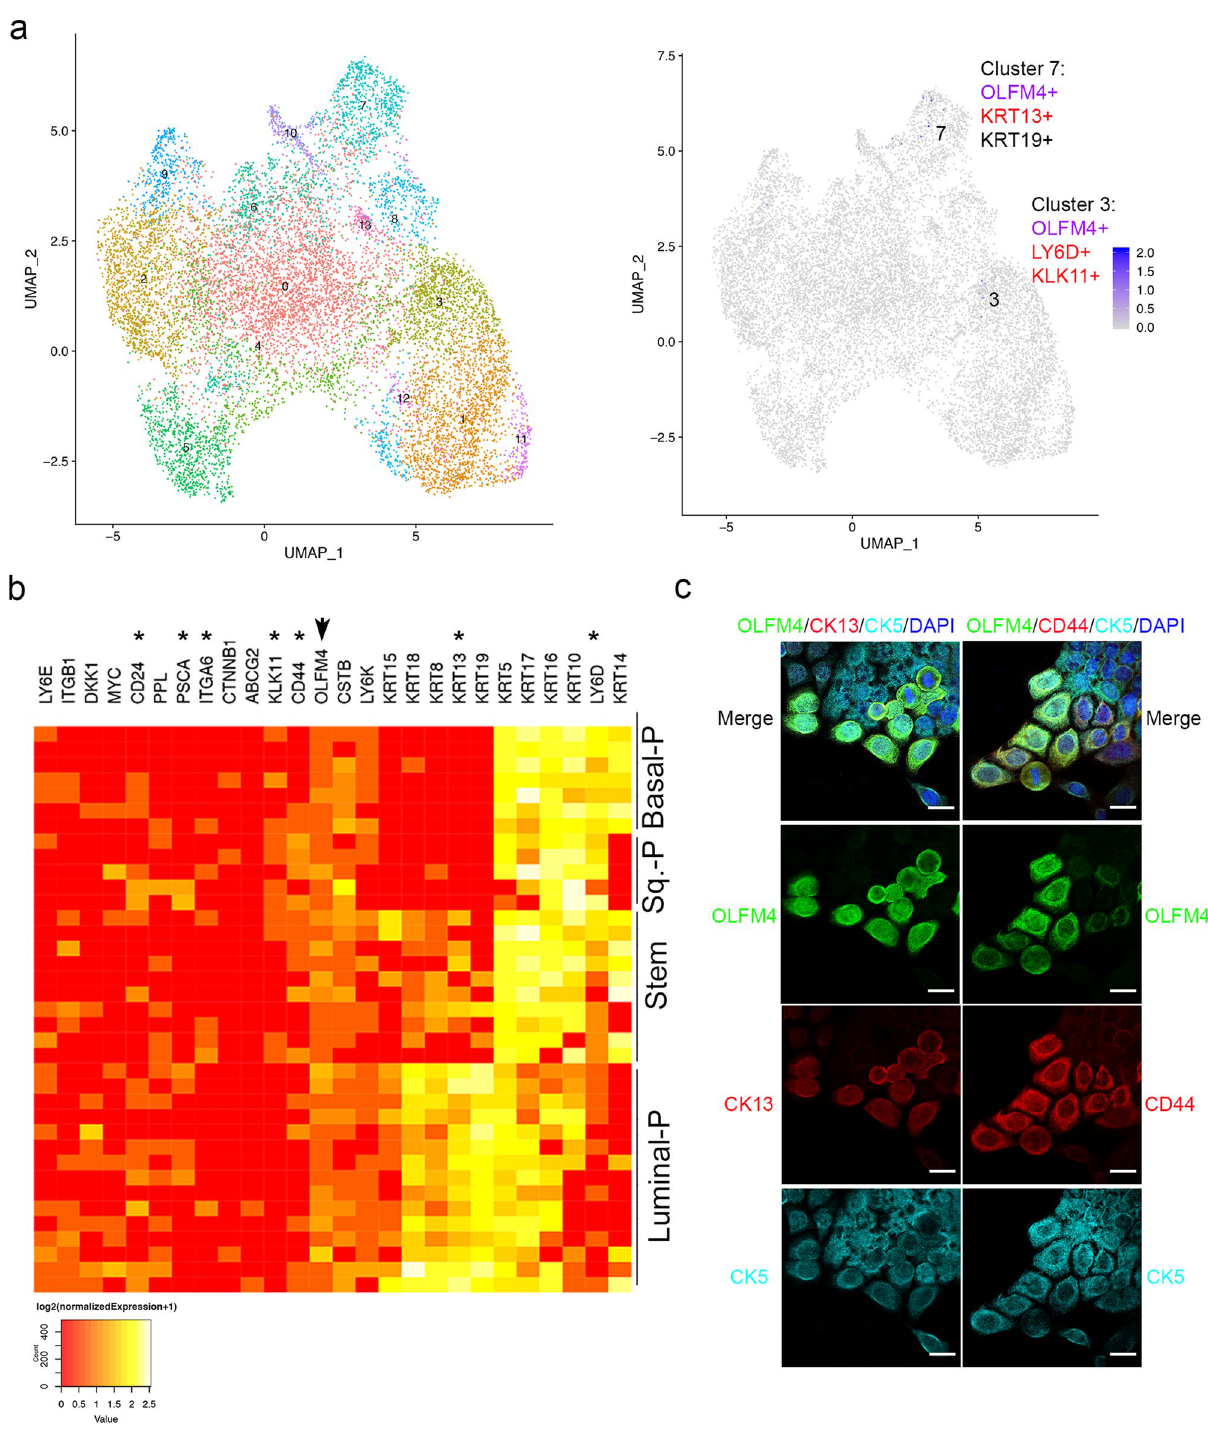
Figure 2. Identification of OLFM4 -expressing RWPE1 cells. ( a ) Uniform Manifold Approximation and Projection (UMAP) plots of integrated data from single-cell RNA sequencing of RWPE1 cells. Left panel shows 13 clusters of total RWPE1 cells; right panel shows OLFM4-expressing cells (purple color) in clusters 3 and 7. ( b ) Heat map illustrates OLFM4 co-expression with stem/progenitor-cell marker genes, cytokeratins, and others in 37 OLFM4-expressing RWPE1 cells. Sq., squamous. P, progenitor. *Indicates lines for stem/progenitor-cell marker genes; arrow indicates line for the OLFM4 gene. ( c ) Representative triple-color immunofluorescent staining of RWPE1 cells. OLFM4 (green); CK13 and CD44 (red); CK5 (cyan); DAPI (blue). Scale bar: 20